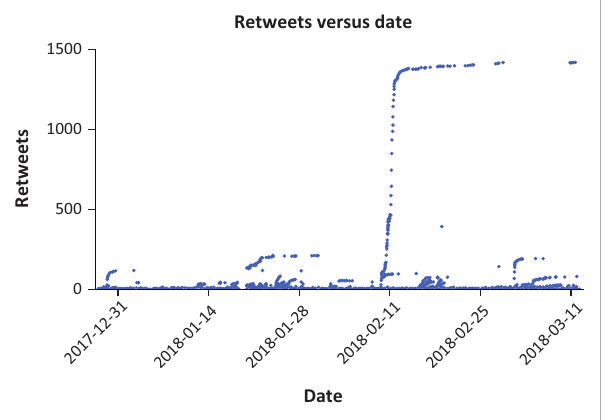
FIGURE 1: Retweet trends .